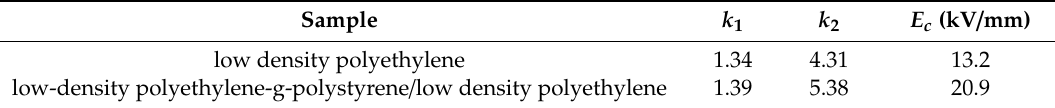
Table 1. The slopes at lower and higher electric field k 1 , k 2 and the critical electric field E c . Sample